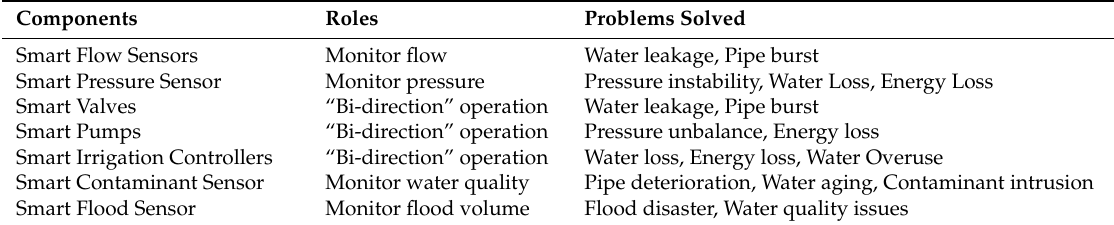
Table 2. Components of Cyber-Infrastructure.